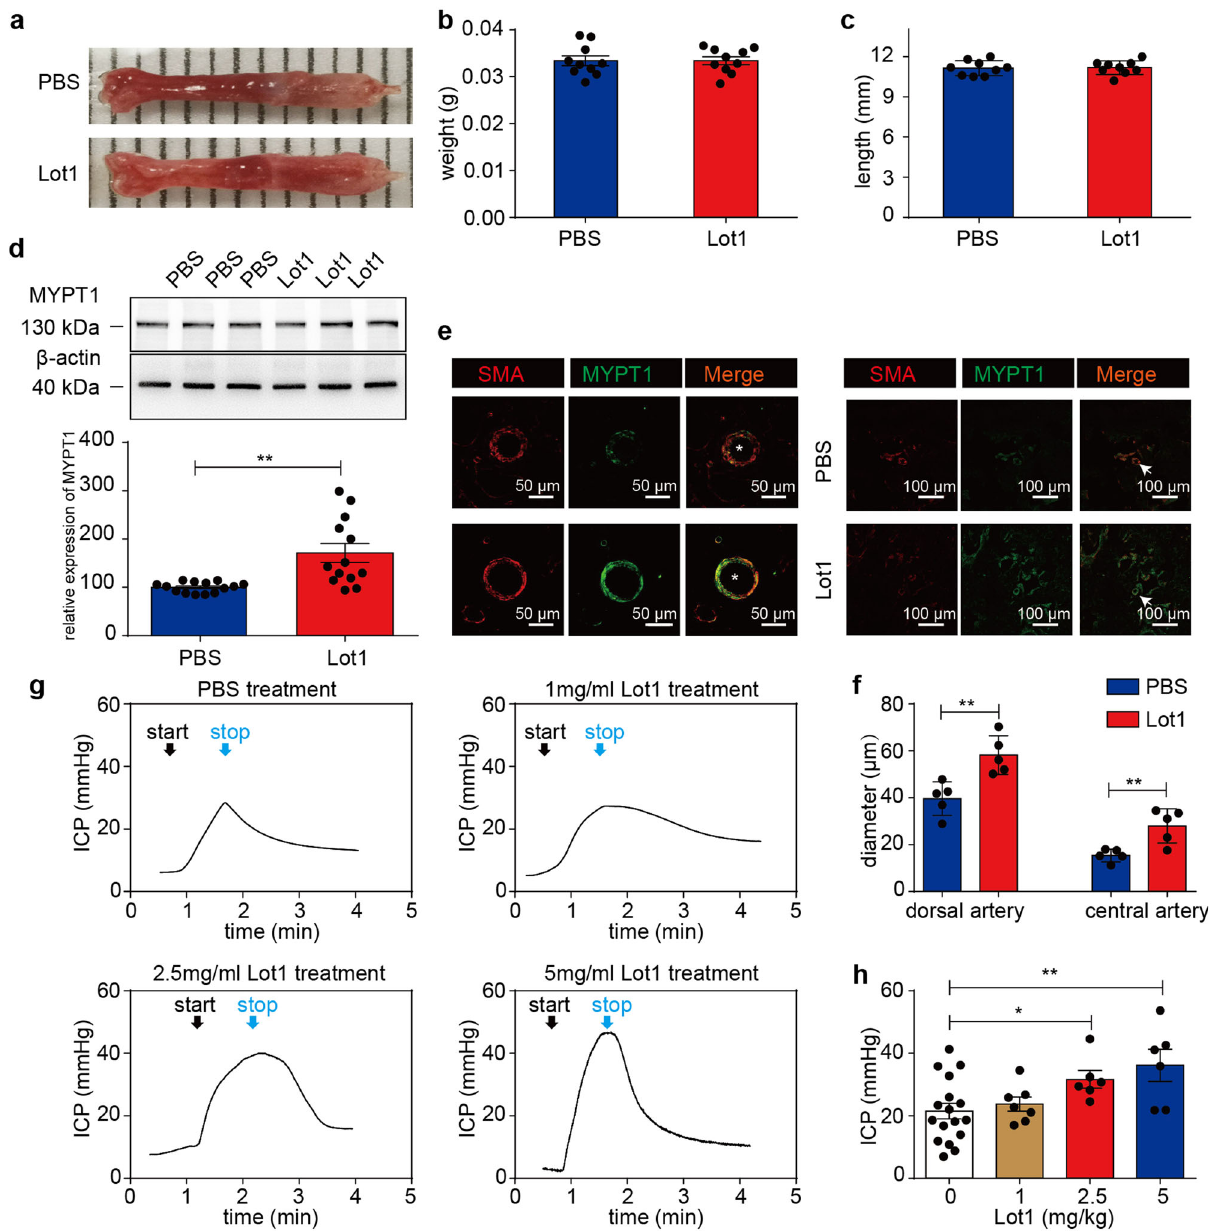
Fig. 7 Lotusine improved the ICP response to electric stimulation in db/db mice. a – c The penile weights and lengths were unchanged after lotusine treatment (Panel b , n = 10; Panel c , n = 9) ( t-test ). d Western blot analysis showed increased in MYPT1 expression in penis after Lot1 treatment (PBS, n = 14, Lot1, n = 13) ( Welch ’ s t-test ). e Immuno fl uorescence staining showed an increase in penile MYPT1 expression after Lot1 treatment. f , Quantitation of the diameters is presented in panel. ( n = 5) ( t-test ). g Representative ICP tracings in db/db mice with (0, 1, 2.5 or 5 mg/kg) lotusine treatment. h , Quanti fi cation of the ICP values in the different groups of mice (0 mg/kg, n = 17; 1 mg/kg, n = 7; 2.5 mg/kg, n = 6; 5 mg/kg, n = 6) ( One-way ANOVA ). The bars indicate the mean values ± SEM; * p < 0.05; ** p < 0.05. ‘ Lot1 ’ indicates the group that received lotusine treatment. “ asterisk ” represents dorsal artery; “ arrow ” represents